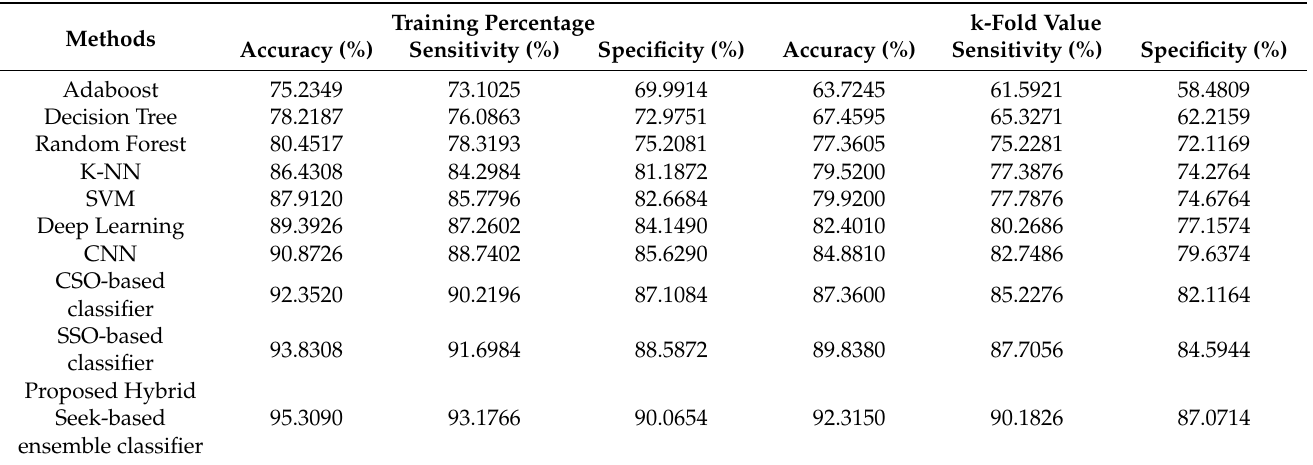
Table 3. Comparison of methods using the Siena Scalp